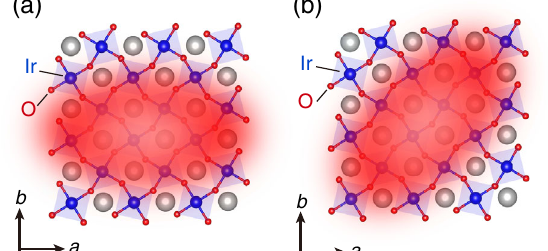
FIG. 5. (a) Schematic picture of the nematicity with B 1 g symmetry, where the nematic director is along the Ir-Ir [100] ≠ χ ¼ 0 . (b) Nem- direction. For this nematicity, χ and χ aa bb ab aticity with B 2 symmetry, where the nematic director is along g ¼ χ the [110] Ir-O-Ir direction. For this nematicity, χ aa bb ≠ 0 . and χ ab